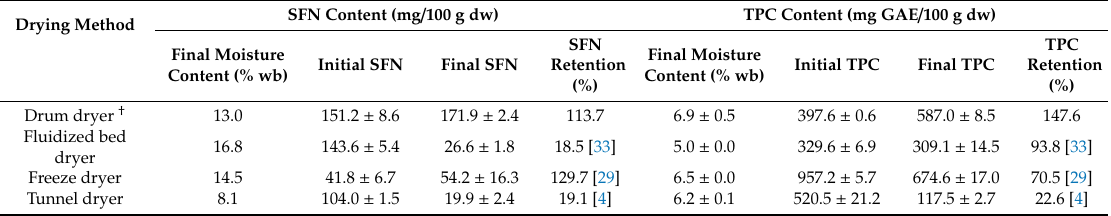
Table 4. Comparison of sulforaphane and total phenolic compounds in broccoli subjected to di ff erent drying